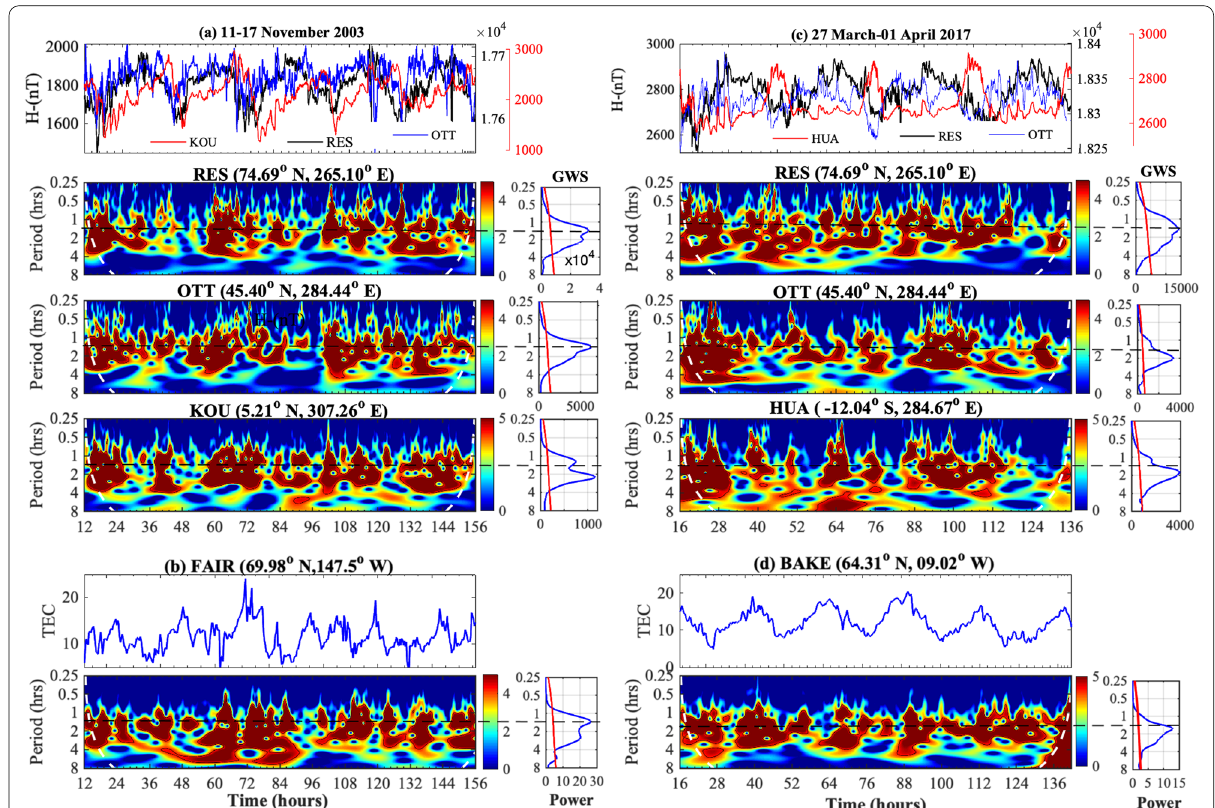
Fig. 4 This figure is similar to Fig. 2, but for the magnetic field and TEC measurements. The top left panel shows a the temporal variations in the H-component of the geomagnetic field for three latitudinally well-separated stations RES (black), OTT (blue), and KOU (red) for the 2003 event. The top right panel shows the c variations of the H-component of magnetic field for the stations’ RES (black), OTT (blue), and HUA (red) for the 2017 event. The corresponding wavelet spectra are provided in the middle panels for the similar period, as mentioned in Fig. 2. The bottom panels show the temporal variations of VTEC b FAIR, and d BAKE stations, and the corresponding wavelet spectra are also provided in the bottom